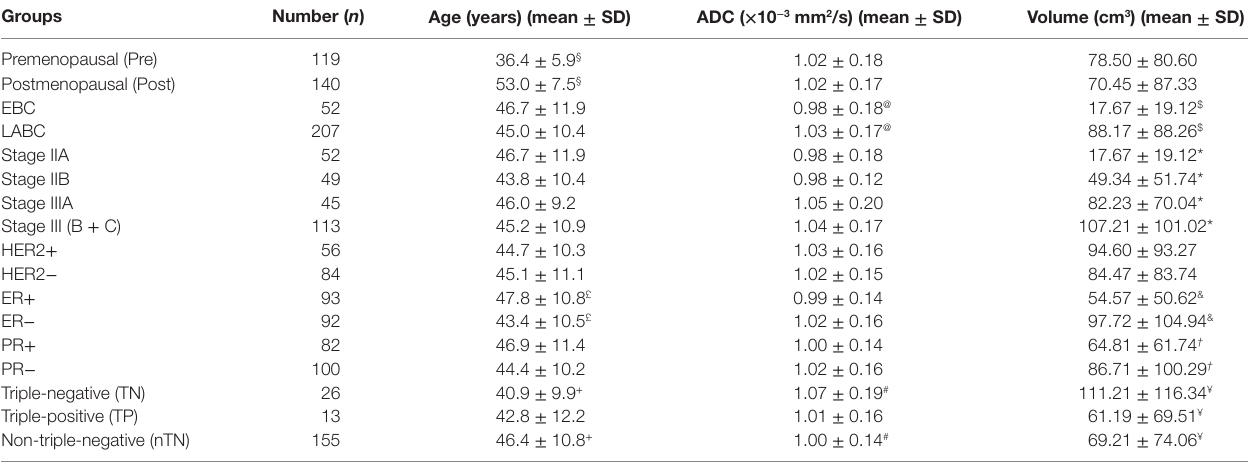
TaBle 6 | Distribution of mean aDc, age, and volume in various subgroups of breast cancer patients based on tumor stage, menopausal, and hormonal biomarker status. groups